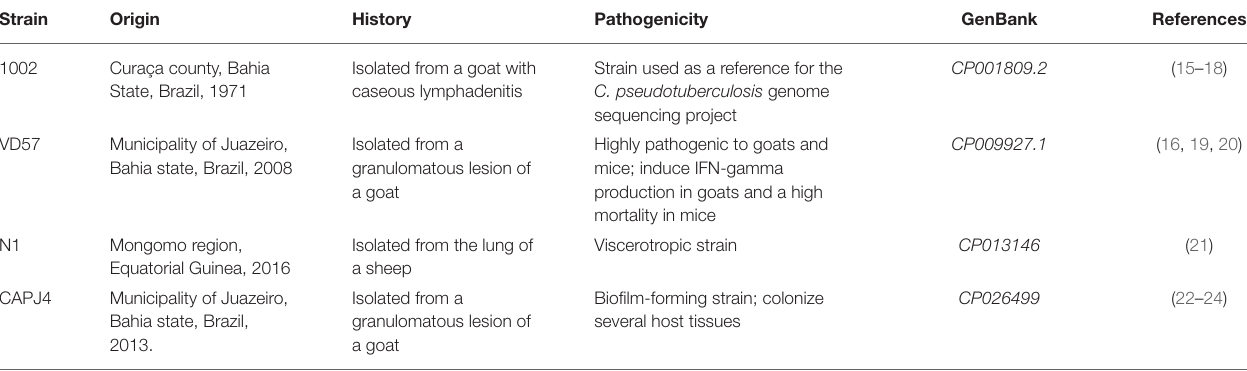
TABLE 1 | Characteristics of the Corynebacterium pseudotuberculosis strains used in this study. Strain